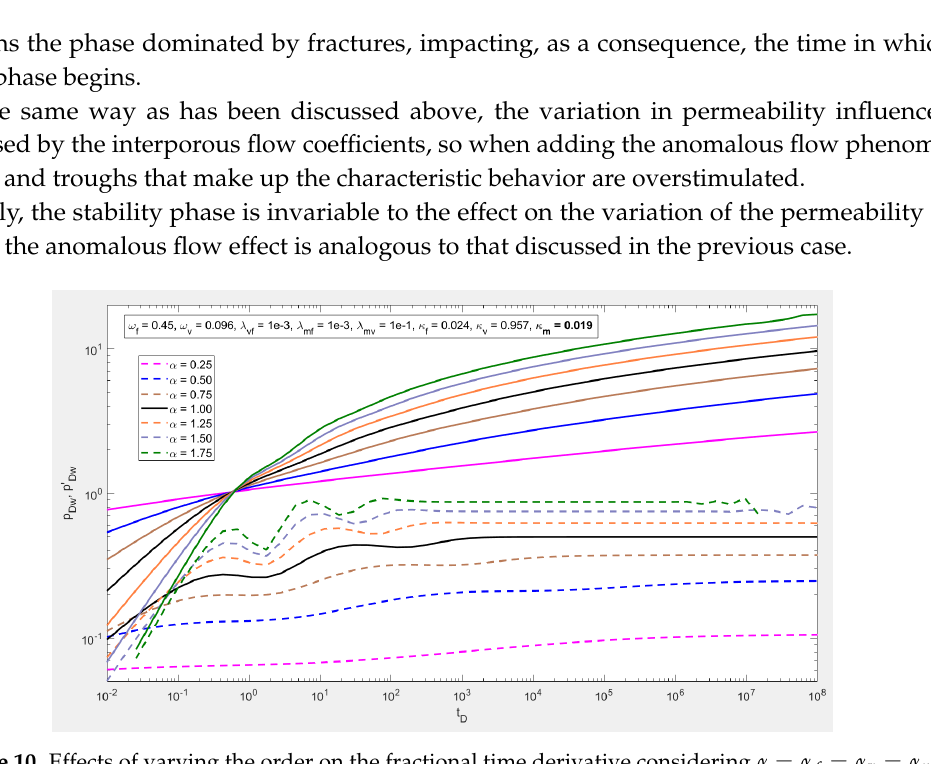
Figure 10. Effects of varying the order on the fractional time derivative considering α = α f = α v = α m .